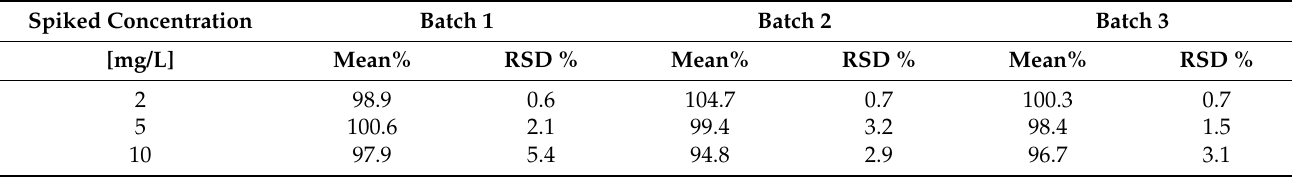
Table 3. Assessment of recovery by the analysis of three batches of CSF, each was analyzed four times. Spiked